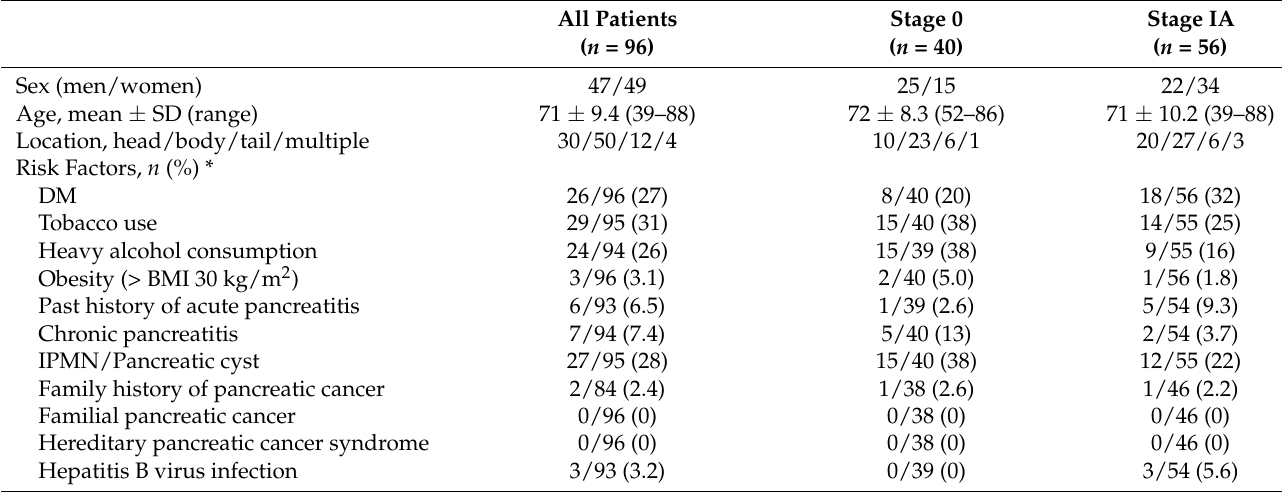
Table 1. Clinical characteristics of 96 patients with stage 0 and IA pancreatic ductal adenocarcinoma (PDAC). All Patients